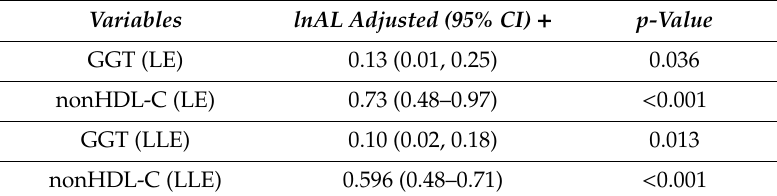
Table 4. Simple linear regression—relationship of AL with cardiovascular-markers in lead-exposed (LE) and less lead-exposed (LLE) individuals at the 3 µ g / dL